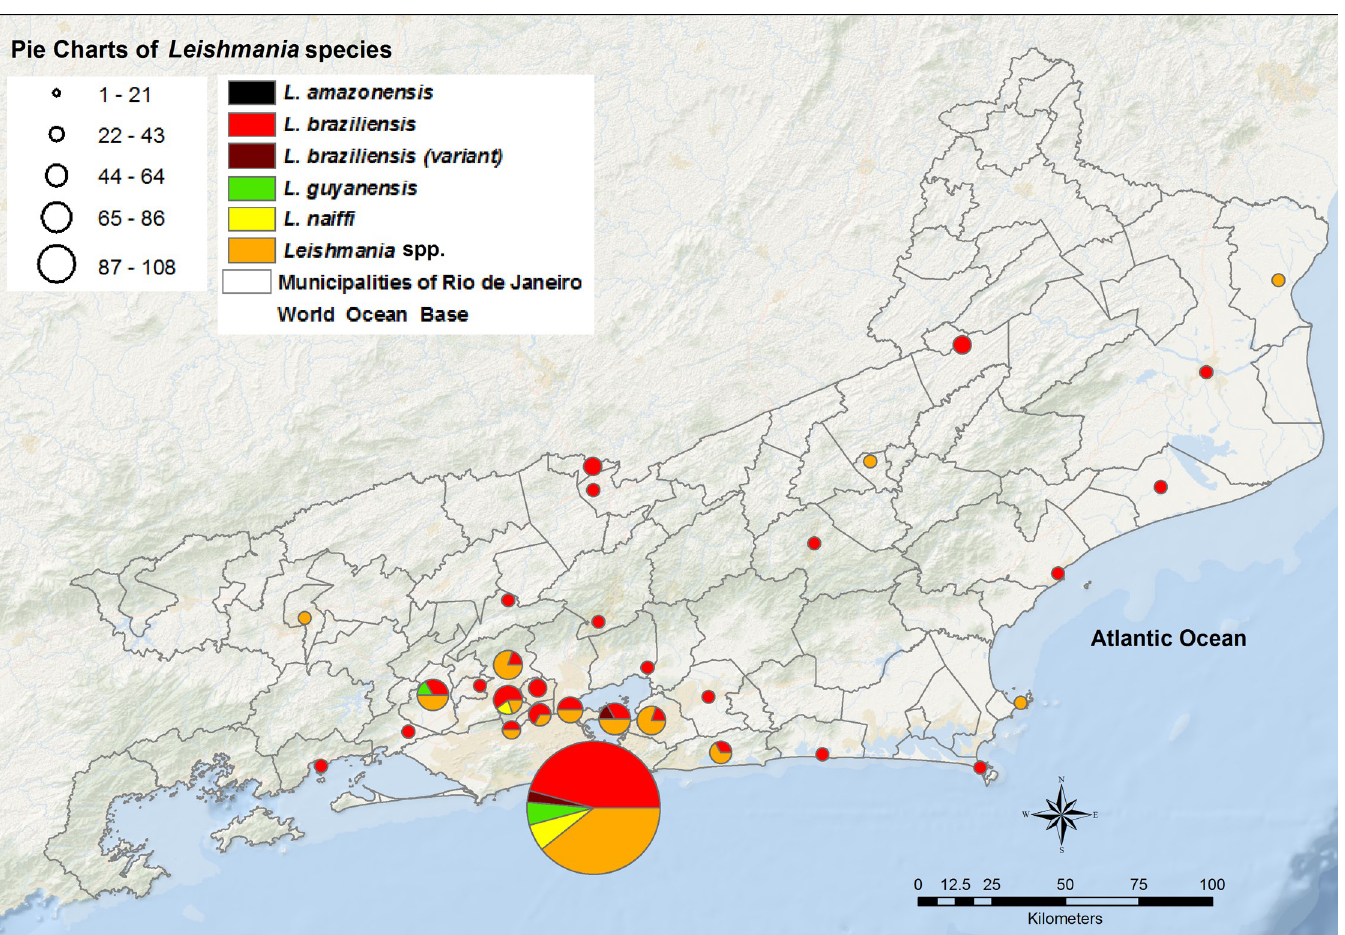
Fig 4. Pie charts of Leishmania species, representing the aggregated distribution of Leishmania species by municipalities of Rio de Janeiro state. The size of pie chart is proportional to the amount of samples of Leishmania in each municipality. Uncharacterized species were represented by an orange color ( Leishmania spp.). This map was created using ArcGIS 9.1 software and cartographic bases obtained from the Brazilian Institute of Geography and Statistics (https://ibge.gov.br/).